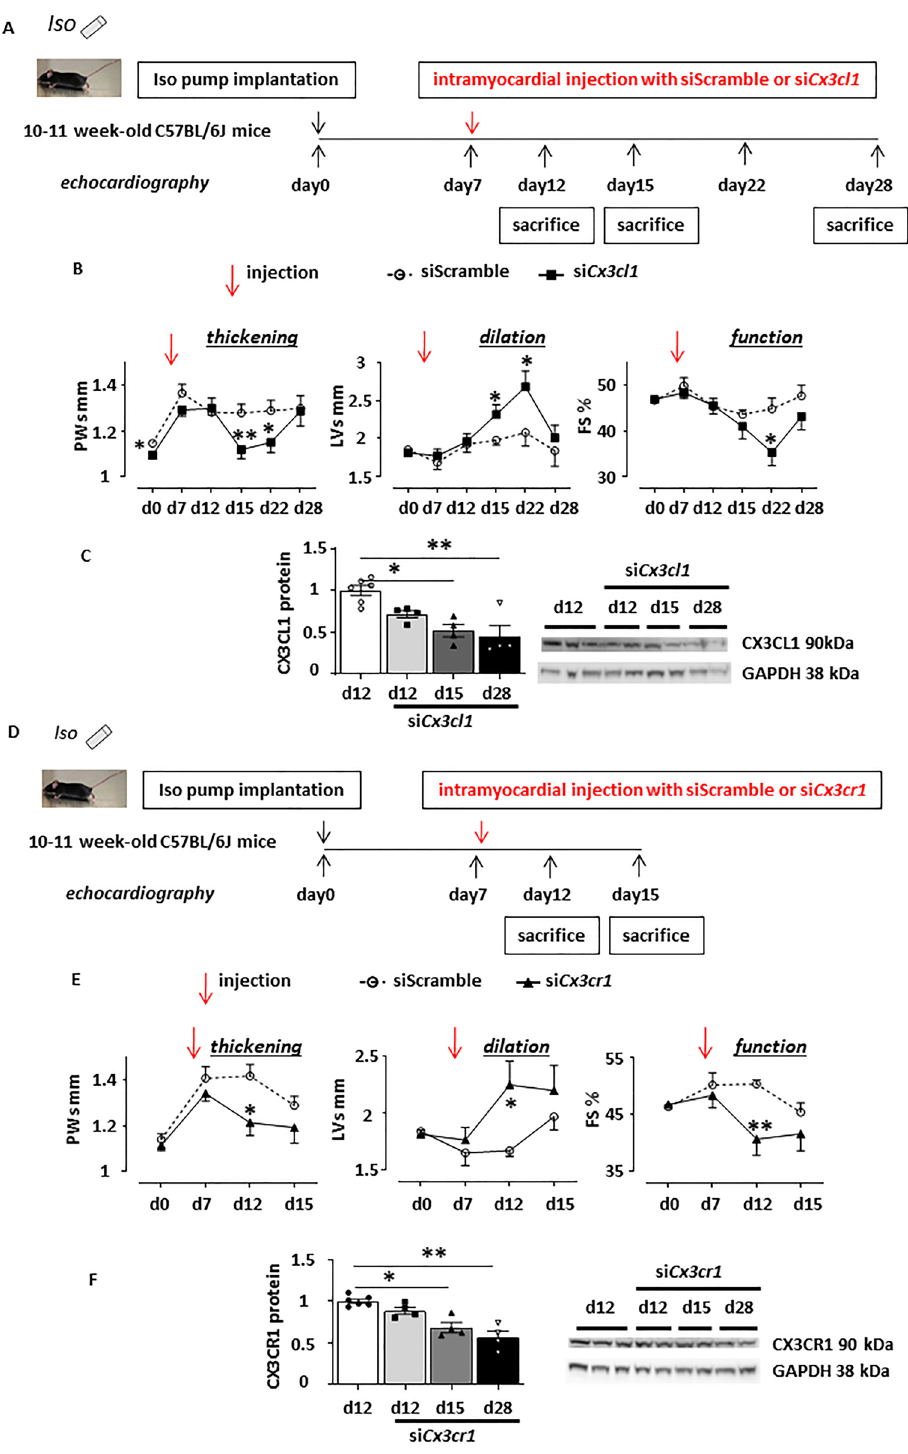
Figure 6. Cardiac CX3CL1 or CX3CR1 knockdown at the onset of ECH, via intramyocardial siRNA injection, reverses iso-induced concentric hypertrophy and favors alteration of function and dilation. ( A , D ) Schematic representation of the protocol where mice implanted with an iso-pump at day 0 were subjected to a unique ultrasound-guided intramyocardial transthoracic injection of Scramble, Cx3cl1 or Cx3cr1 siRNAs at day 7. ( B , E ) Echocardiographic parameters measured at d0, d7, d12, d15, d22 and d28 concerning siScramble or si Cx3cl1 injections; n = 5–13 mice/group. Measurement at d0, d7, d12 and d15 for siScramble or si Cx3cr1 injections; n = 10–14 mice/group, two-way ANOVA followed by Sidak’s post-hoc tests; * p < 0.05, ** p < 0.01 vs scramble at the same time point. ( C , F ) Efficient knockdown of CX3CL1 or CX3CR1 protein levels in cardiac homogenates at d12, d15 and d28 following siRNA injection. Full unedited gels are in the supplementary material as well as detailed procedure (Figure S12 and S13). Mean ± SEM of mice, n = 4–6 mice/group, Kruskal–Wallis followed by Dunn’s post-hoc tests; * p < 0.05, ** p <